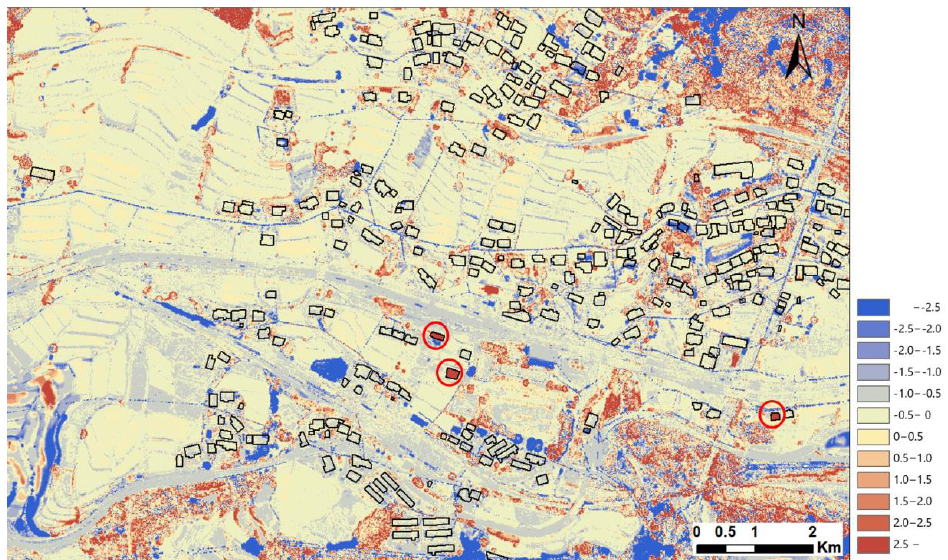
Figure 8. DSM difference in the co-event period (2013.1–2016.4) for Tateno district with building footprints [40]. The three red-circled buildings were newly built during this period.